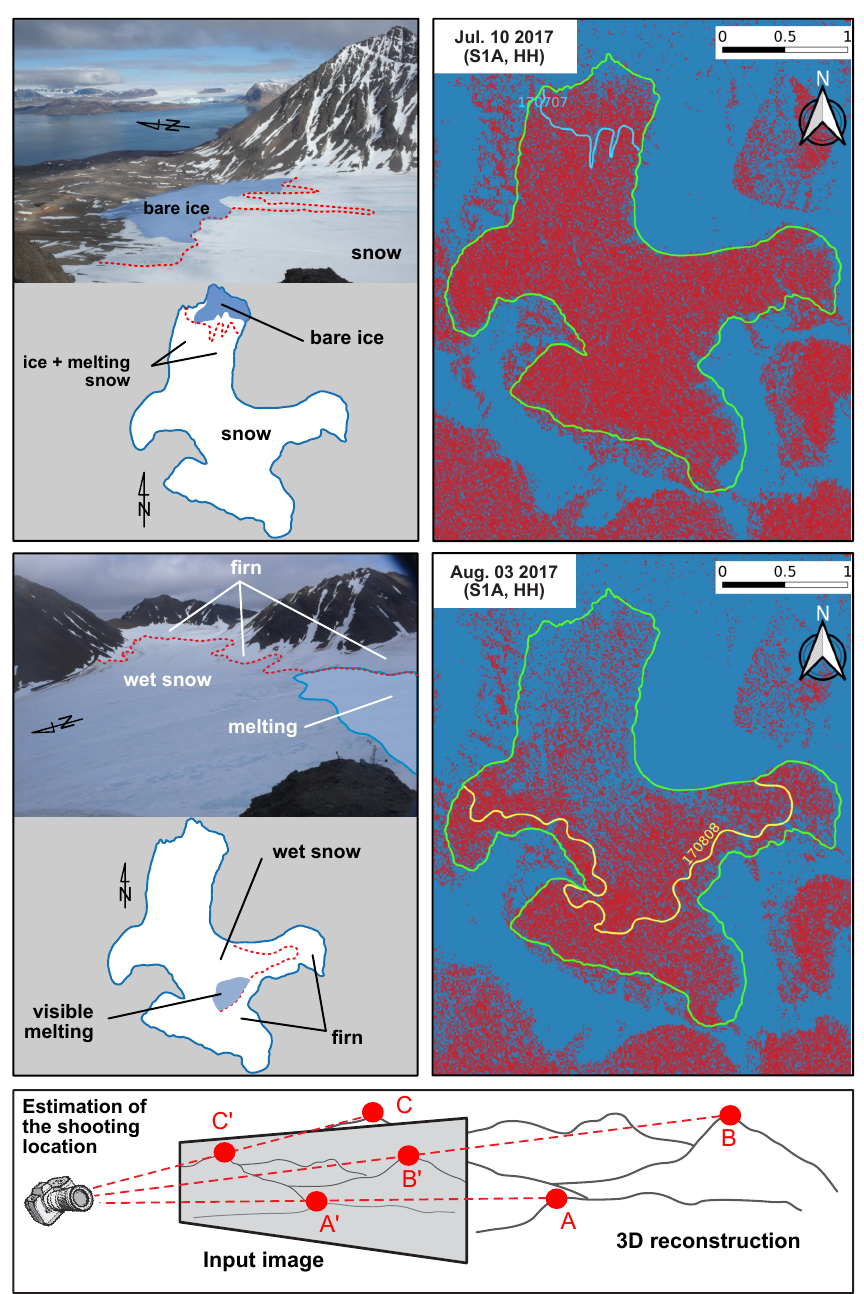
Figure 3. Comparison of the raw image acquired by the oblique-view automated camera ( top-left ), the orthorectified image with the manual delineation of the snow–ice limit ( bottom-left ) and ( right ) the Sentinel-1 RADAR-reflected intensity map displayed after applying a binary thresh- old, with blue the strongly reflecting areas and red the strongly absorbing areas. Top data were collected 10 July 2017 and bottom data were collected 3 August 2017. The fractional snow cover limit was delineated on the oblique-view image and displayed on the RADAR maps for comparison. Bottom : principle of the monoplotting processing technique used for projecting the fractional snow cover limit (red line on the left images) on an azimuthal view